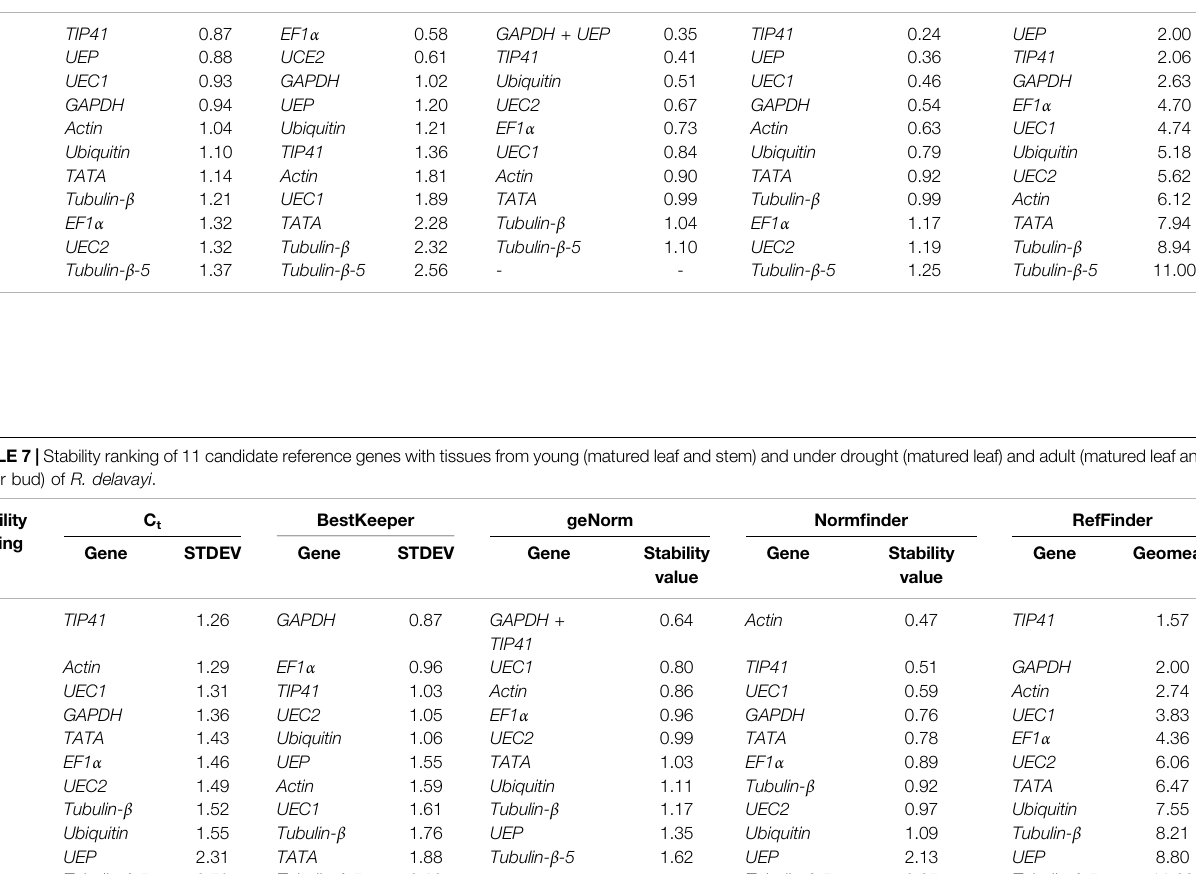
TABLE 6 | Stability ranking of 11 candidate reference genes with tissues (matured leaf and fl ower bud) sampled from adult R. delavayi . Stability C t ranking